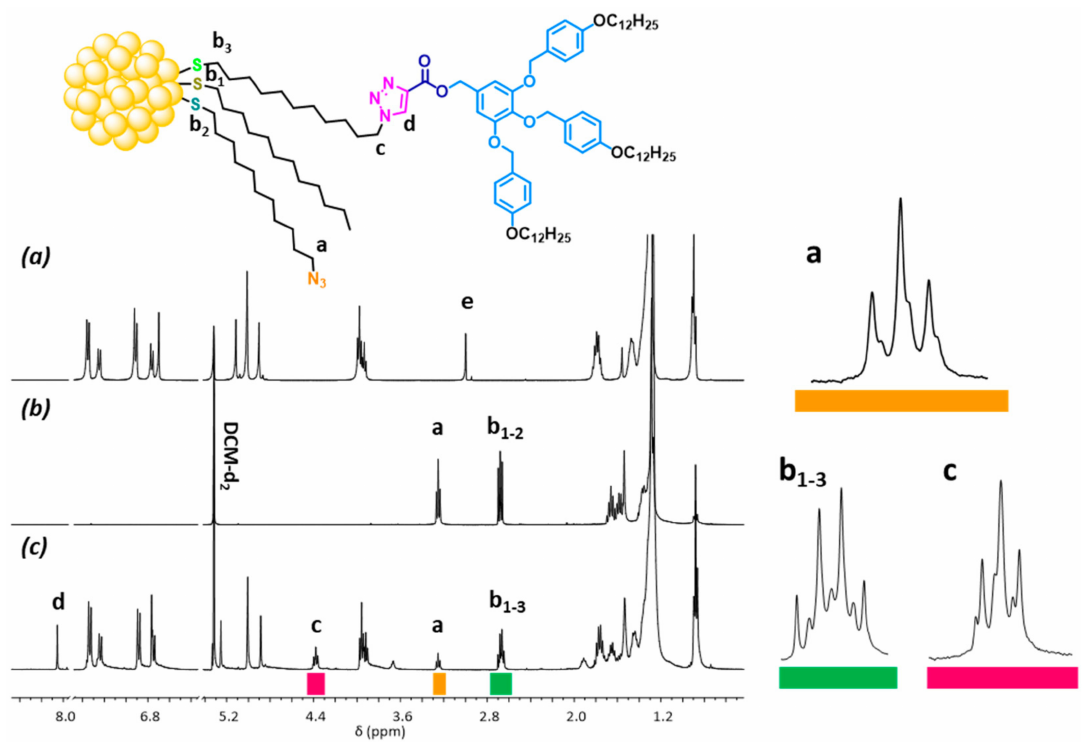
Figure 4. 1 H NMR spectra in DCM-d 2 solution at 25 ◦ C of: ( a ) alkyne-focal point ligand L3-3,4,5, (the signal e corresponds to the alkyne proton), ( b ) AuDT-AT template, and ( c ) AuDT-AT-TA@L3-3,4,5 hybrid